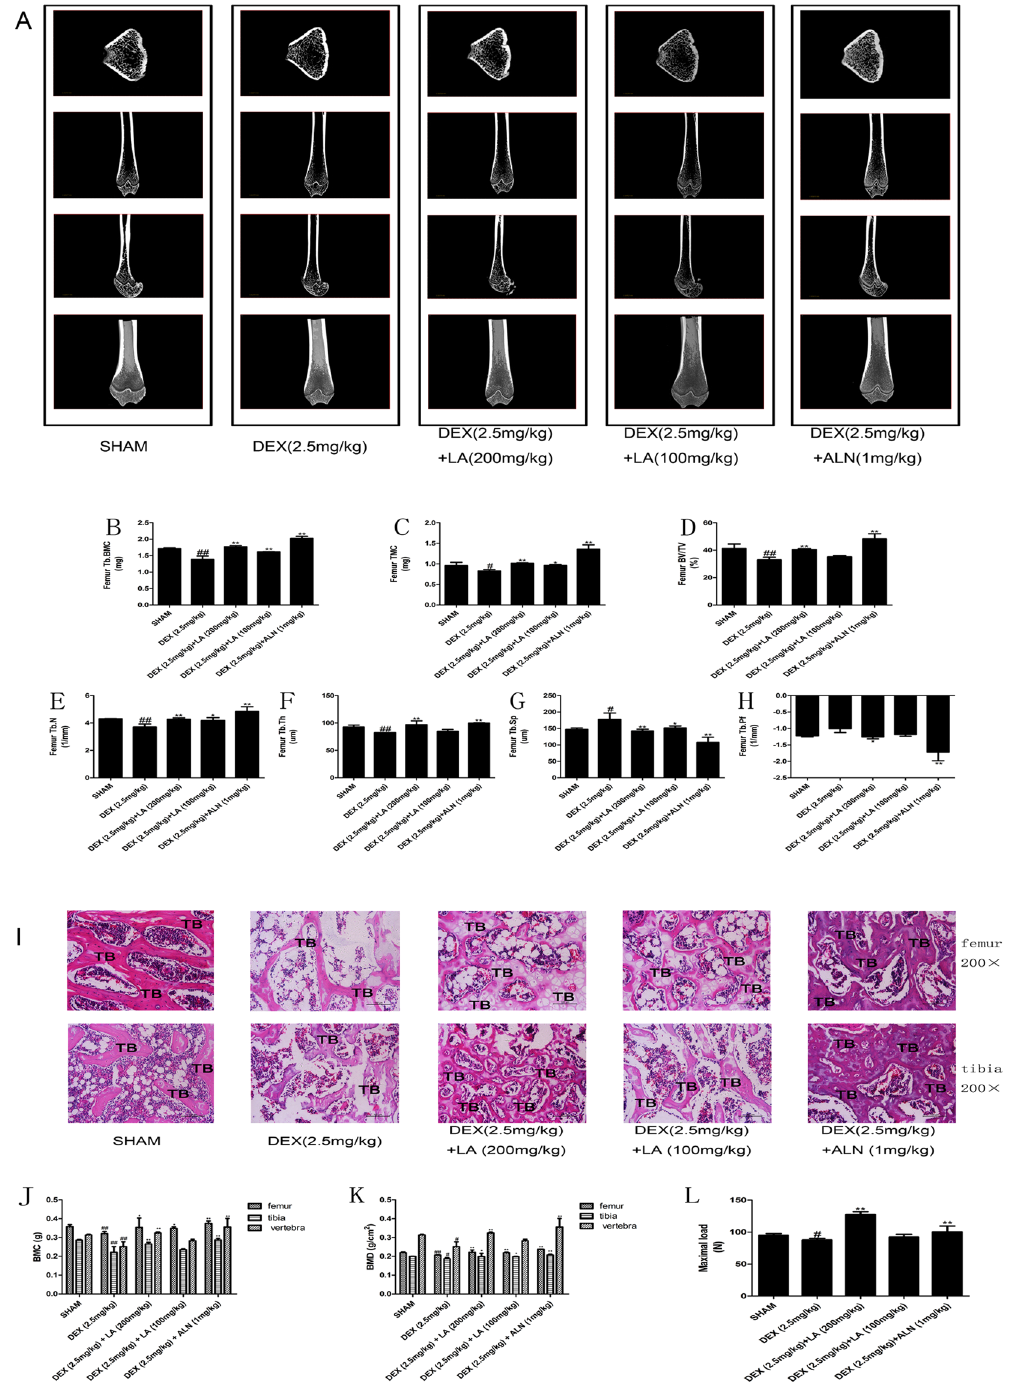
Figure 1. The representative micro-CT images of the femurs in each group ( A ) (n = 3 for each group). Analysis of the distal femoral trabecular bone parameters by micro-CT. Tb.BMC ( B ), TMC ( C ), BV/TV ( D ), Tb.N. ( E ), Tb.Th. ( F ), Tb.sp. ( G ), Tb.pf. ( H ) Data were the means ± SD (n = 3 for each group). # P < 0.05 and ## P < 0.01, vs. the SHAM group. * P < 0.05 and ** P < 0.01, vs. the DEX group. The static histomorphometric analysis of femur and tibia by hematoxylin & eosin staining ( I ) (n = 3 for each group). All images of H&E staining were at × 200 magnifications. Bars: 100 μ m. TB: trabecular. BMC and BMD of femur, tibia and vertebra (n = 6 for each group). BMC were determined in each of the five groups ( J ). BMD was calculated on the basis of BMC ( K ). Evaluation of biomechanical properties on femur by using a three point blending test ( L ) (n = 3 for each group), It was calculated from load-displacement curves. # P < 0.05 and ## P < 0.01, vs. the SHAM group. * P < 0.05 and ** P < 0.01, vs. the DEX